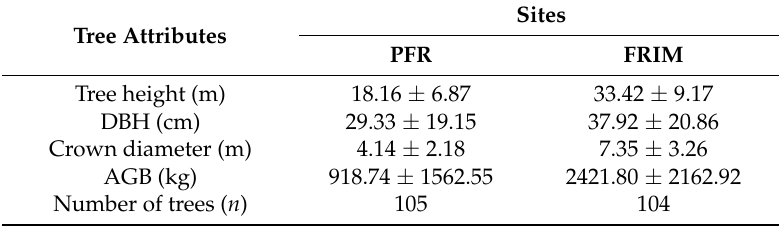
Table 1. Characteristics of individual tree field sample data from both forest sites, mean ± SD ( n ). Tree